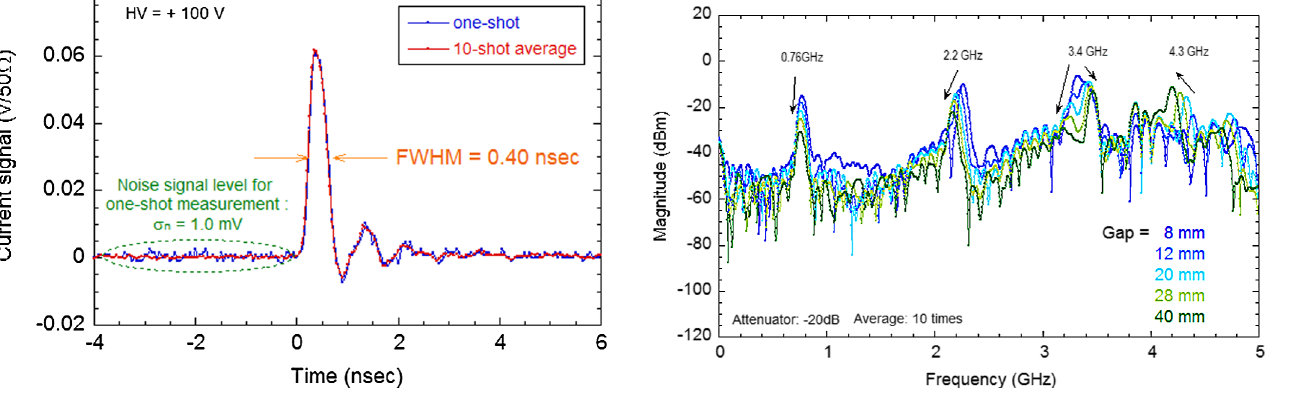
FIG. 11. Spectrum of the signal caused by the induction